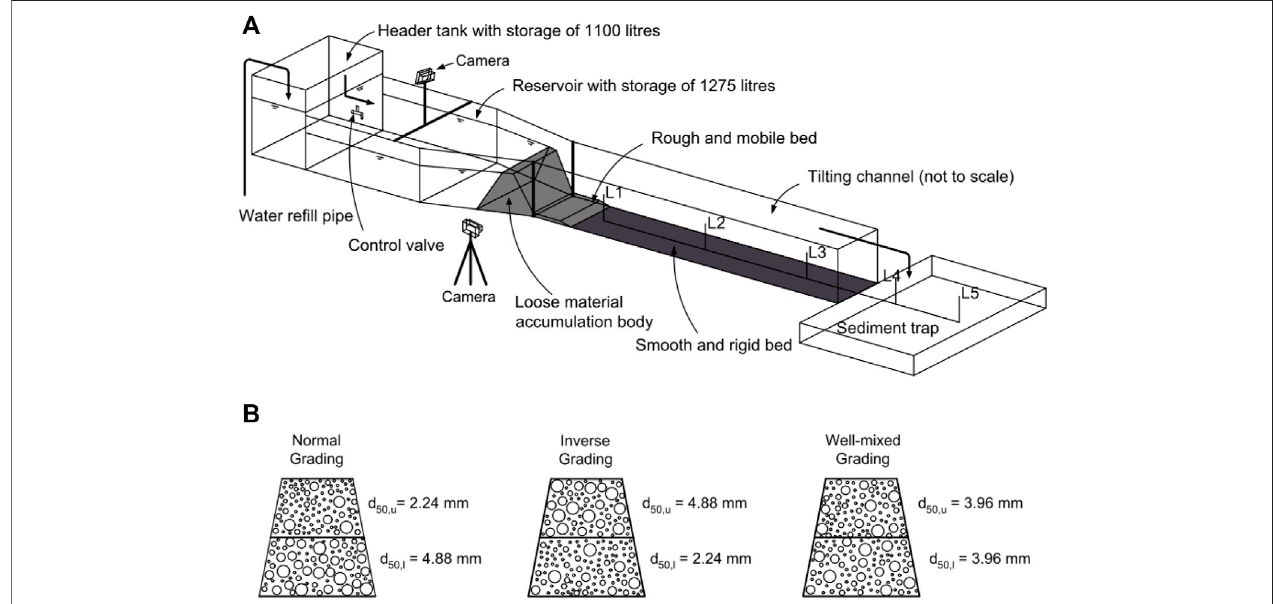
FIGURE 1 | Schematics of experimental arrangement (A) and three vertical grading structures originated from corresponding con fi gurations with lower layer medium grain size d 50 being coarser, fi ner, or nearly equivalent to the upper layer d 50 within arti fi cial dam (B) .